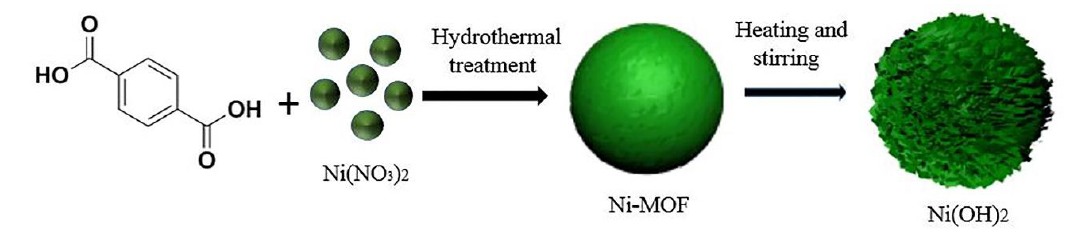
Figure 5. Schematic illustration of the fabrication mechanism of Ni(OH) 2 .